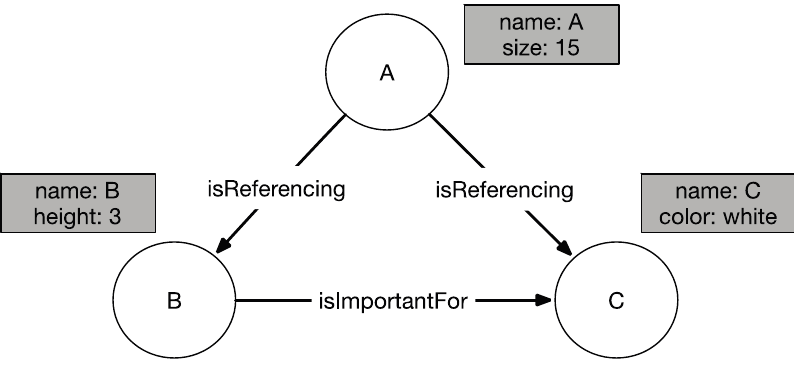
Figure 1. Simple graph network of three nodes with their values and